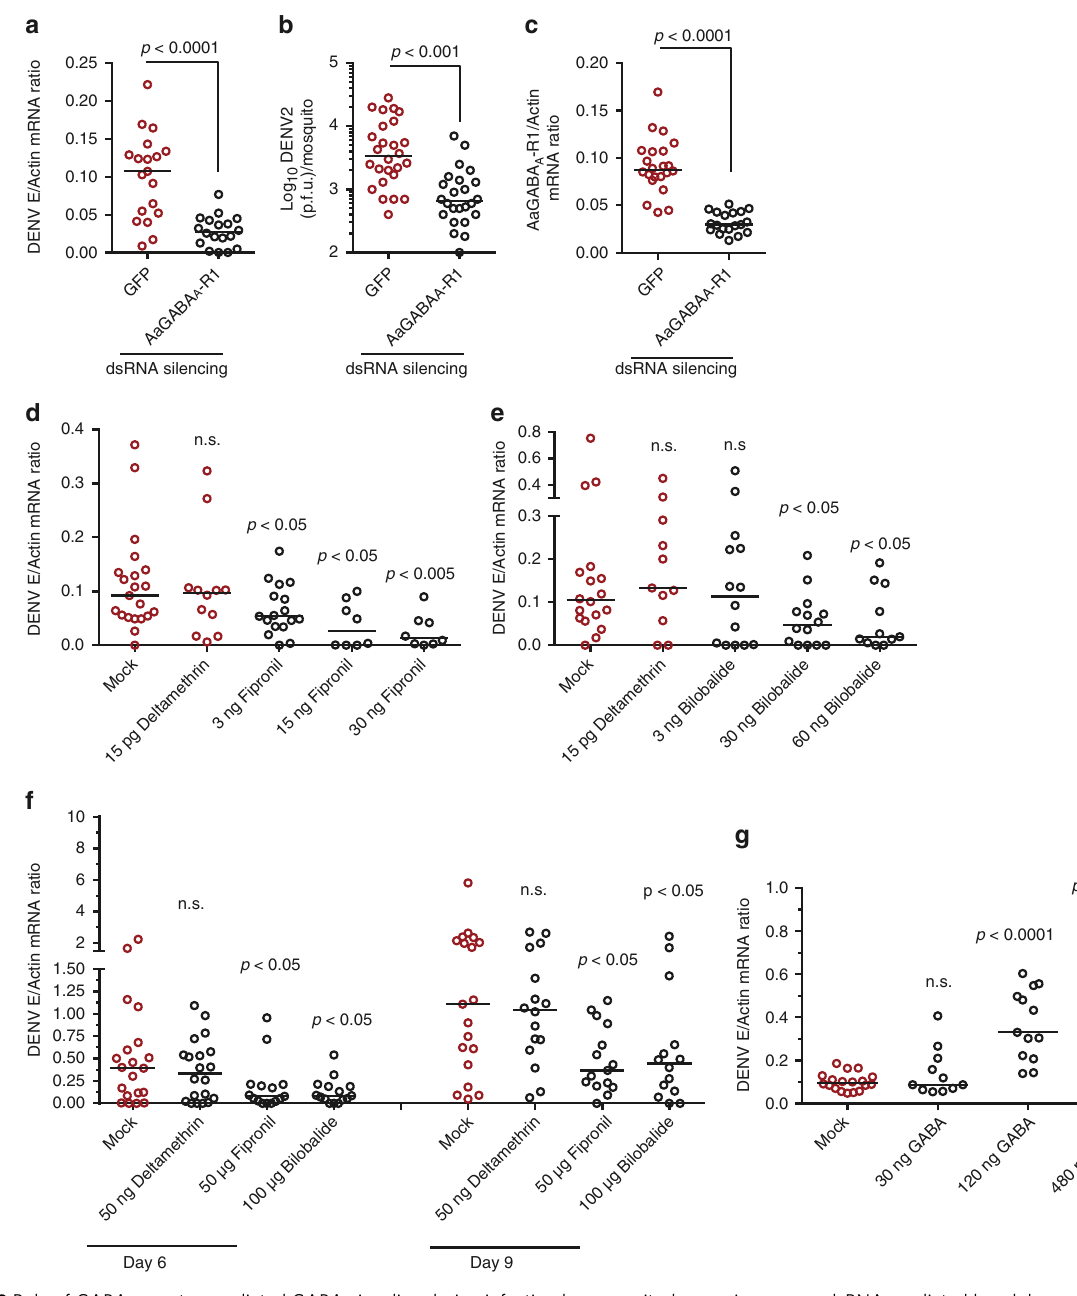
Fig. 2 Role of GABA receptor-mediated GABA signaling during infection by mosquito-borne viruses. a – c dsRNA-mediated knockdown of the AaGABA A -R1 gene impaired DENV-2 infection in A. aegypti . a , b Silencing of AaGABA A -R1 enhanced DENV-2 infection as measured by qPCR a and a plaque assay b . The viral loads were assessed on 6 days post-infection via a plaque assay. c dsRNA-mediated knockdown of the AaGABA A -R1 gene in mosquitoes. Mosquitoes inoculated with GFP dsRNA served as negative controls. The AaGABA A -R1 abundance was assessed by SYBR Green qPCR on 6 days post dsRNA microinjection. Ten M.I.D. 50 of DENV-2 were inoculated on 3 days post dsRNA inoculation. d , e Thoracic inoculation of GABA receptor-inhibitory insecticides decreased DENV-2 replication in A. aegypti . Either Fipronil d or Bilobalide e was premixed with 10 M.I.D. 50 of DENV-2 and subsequently inoculated into mosquitoes. Mosquitoes inoculated with Deltamethrin and 10 M.I.D. 50 of DENV-2 served as unrelated controls. Mosquitoes inoculated with PBS and DENV-2 served as mock controls. The number on the X-axis represent the amount of insecticides inoculated per mosquitoes. f Insecticide exposure reduced DENV-2 replication in A. aegypti . Mosquitoes infected by oral membrane feeding were exposed to bottles sprayed with Fipronil (50 μ g/bottle) or Bilobalide (100 μ g/bottle) for 2 h. Deltamethrin (50 ng/bottle) served as an unrelated control. Infected mosquitoes exposed to PBS served as mock controls. For mosquito oral infection, 6 × 10 5 p.f.u./ml of DENV-2 was used. Surviving mosquitoes were transferred to new culture containers for further rearing. The viral loads were assessed over time post-infection via TaqMan qPCR and were normalized to A. aegypti actin ( AAEL011197 ). g Thoracic inoculation of GABA facilitated DENV-2 infection in A. aegypti . Serial concentrations of GABA with 10 M.I.D. 50 of DENV-2 were microinjected into mosquito thoraxes. Mosquitoes inoculated with PBS and DENV-2 served as negative controls. The number on the X -axis represents the amount of GABA inoculated per mosquito. a , d , e , g The viral loads were assessed at 3 days post-infection via TaqMan qPCR and were normalized to A. aegypti actin ( AAEL011197 ). a – g One dot represents one mosquito, and the horizontal line represents the median of the results. The data were analyzed statistically using the non-parametric Mann – Whitney test. The results were reproduced at least two times. The primers and probes used for PCR are presented in Supplementary Data